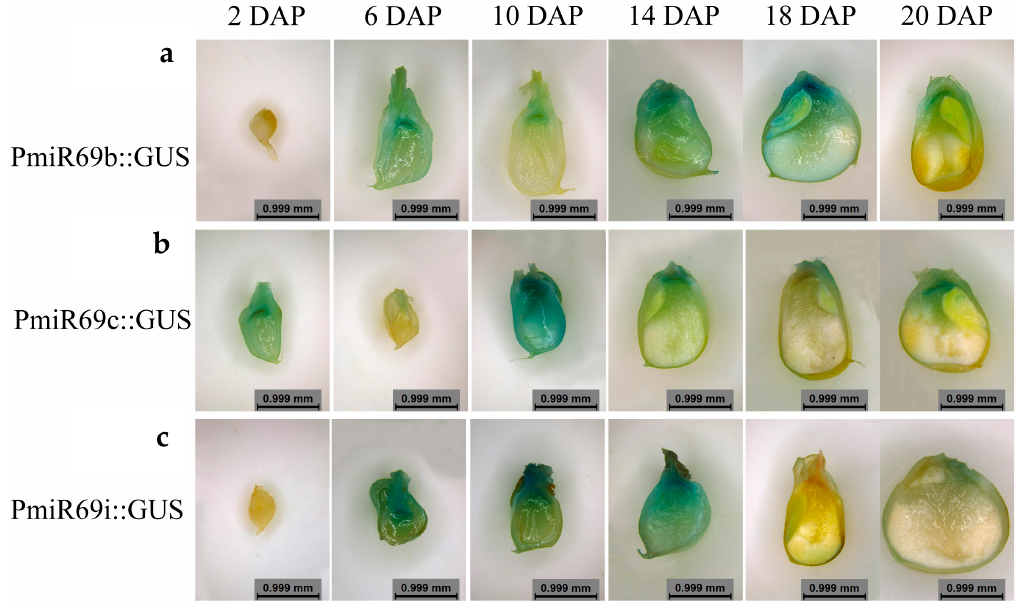
Figure 7. Expression profiles of zma-miR169b ( a ), zma-miR169c ( b ) and zma-miR169i ( c ) in transgenic maize kernels at 2 DAP, 6 DAP, 10 DAP, 14 DAP, 18 DAP and 22 DAP. Plants were planted in a green house with a standard long day (LD) light regime.